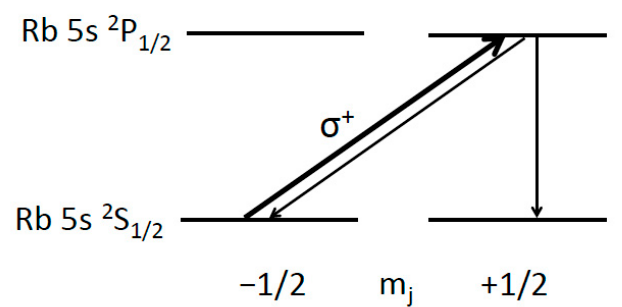
Figure 1. Schematic diagram of Rb optical pumping with circularly polarized ( σ + ) D1 795 nm laser light. Repeated cycles of absorption, emission, and reabsorption produce ground-state Rb that is highly spin polarized. Atoms in the m j = +1/2 “dark” ground state cannot absorb a σ + photon.